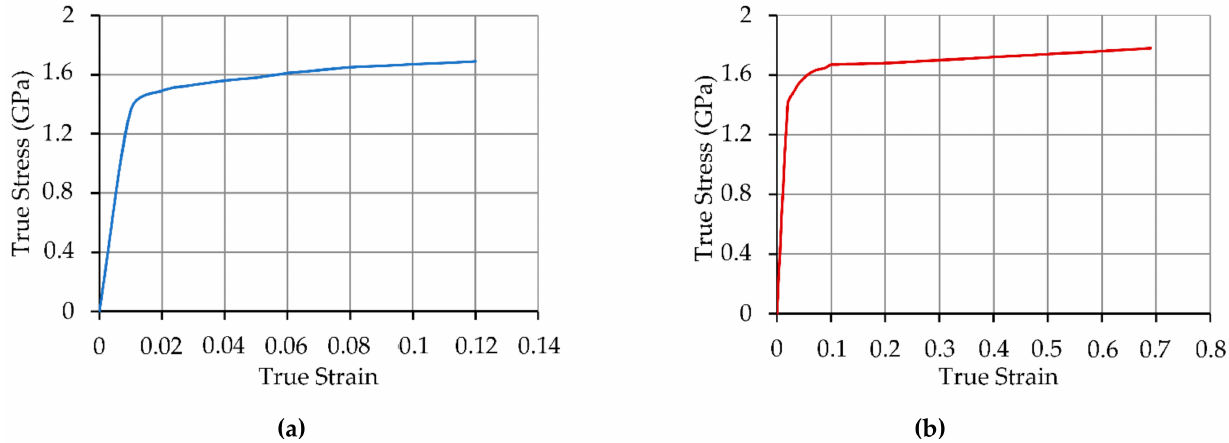
Figure 6. True stress–strain curves of the ARMSTAL 30PM calculated on the basis of mechanical test results (strain rate 10 − 3 s − 1 ): ( a ) tension; ( b ) compression.